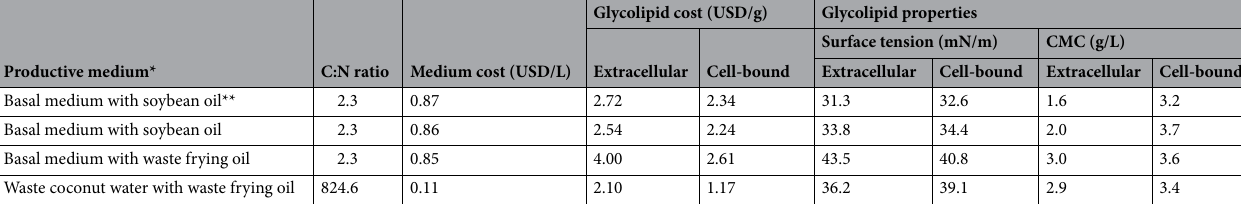
Table 3. Cost of productive media and their C:N ratio. The cost of glycolipids and their properties are also shown. *The costs of productive media were calculated from the price of each component purchased at local markets, while glycolipid costs were based on the glycolipid concentrations obtained from each medium (Table 2). Basal medium price 0.72 USD/L Reference: M&P IMPEX LTD, Thailand. The soybean oil price is 1.57 USD/L, which was purchased from Thai Vegetable Oil Public Company Limited. The waste coconut water price is 0.10 USD/L, which was purchased from the Khlong Toei market, Bangkok, Thailand, and the price of waste frying oil was 0.49 USD/L, which was purchased from Baan Lad, Phetchaburi Province, Thailand. The C:N ratio of each productive medium was determined from the components of basal medium, waste coconut water, soybean oil and waste frying oil. **The data were obtained from Subsanguan et al. 14 , and glycolipid production was carried out in shaking